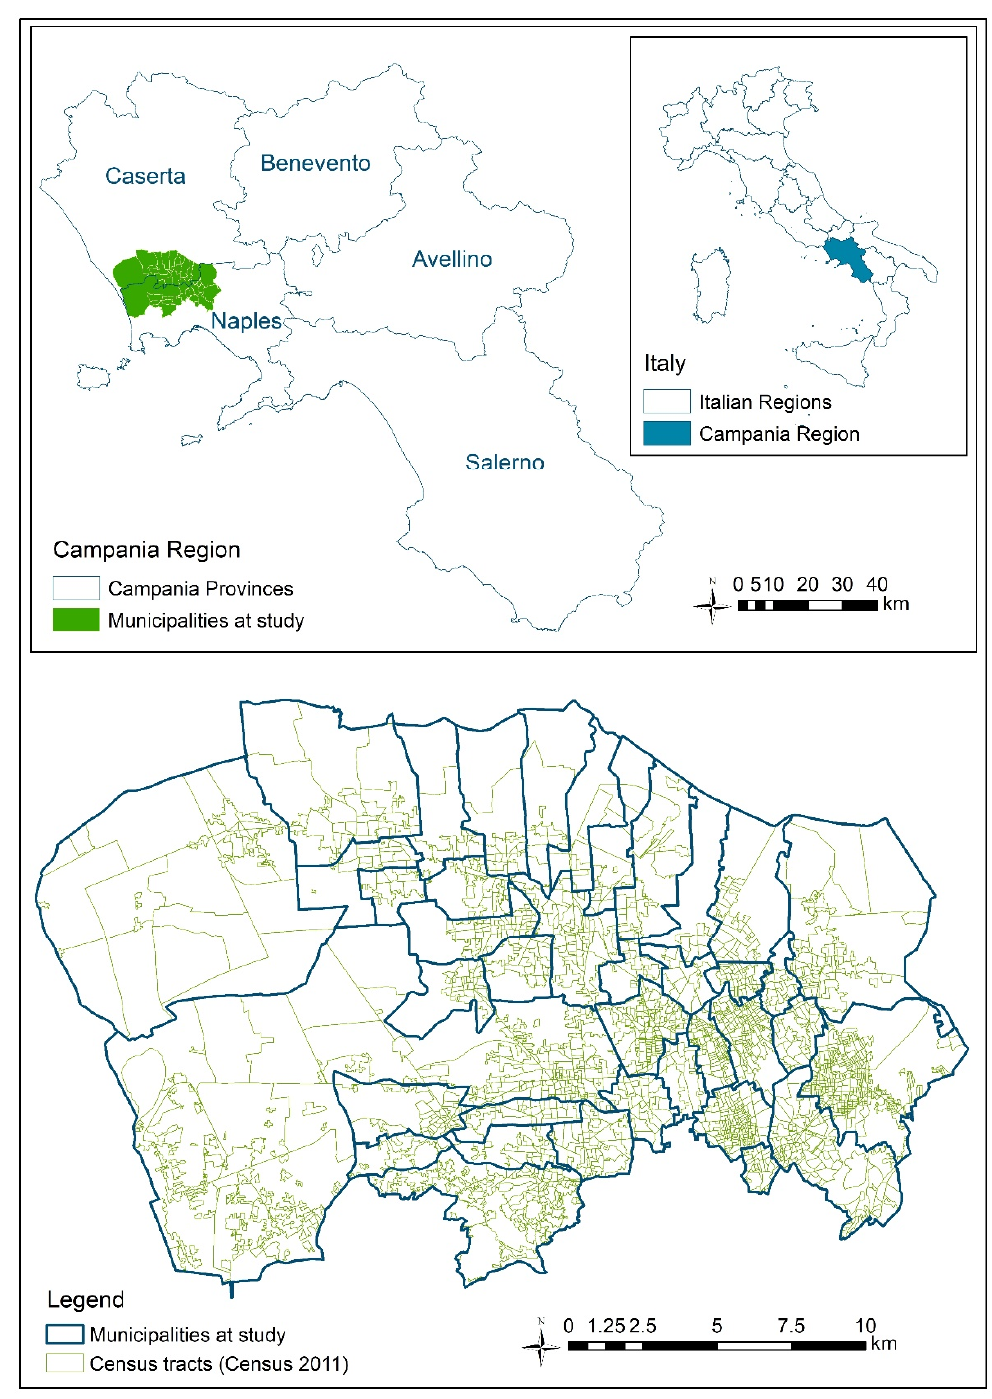
Figure 1. The municipalities at study (Campania Region, Sothern Italy).